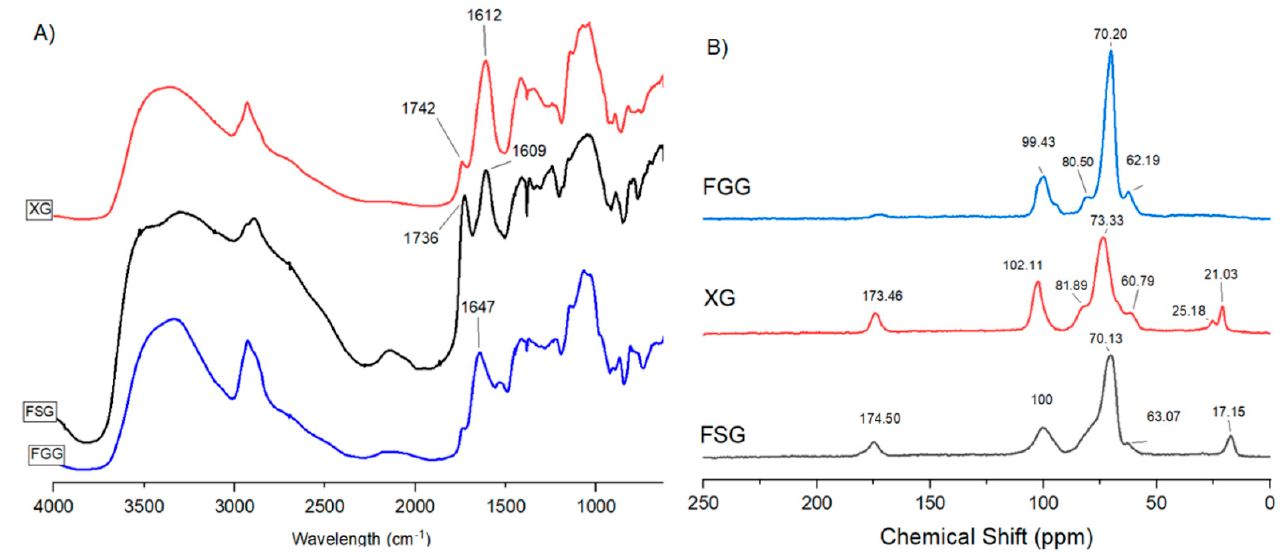
Figure 2. IR and 13 C solids NMR spectra for flaxseed gum (FSG), fenugreek gum (FGG) and xanthan gum (XG): ( A ) FT-IR spectra, ( B ) 13 C solids NMR spectra. gum (XG): ( A ) FT-IR spectra, ( B ) 13 C solids NMR